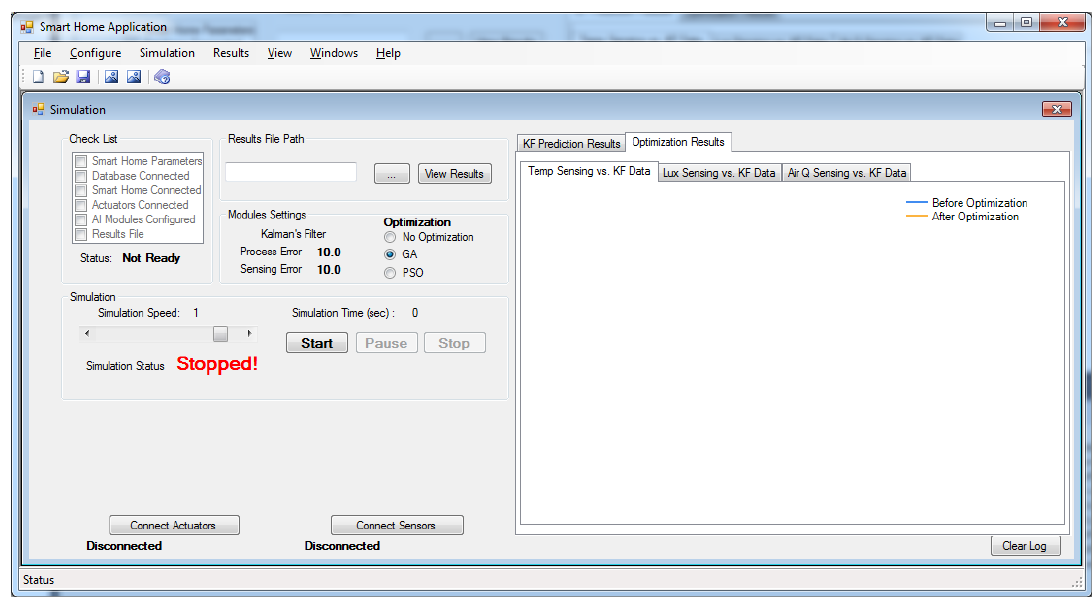
Figure 5. Smart energy management system application main window.